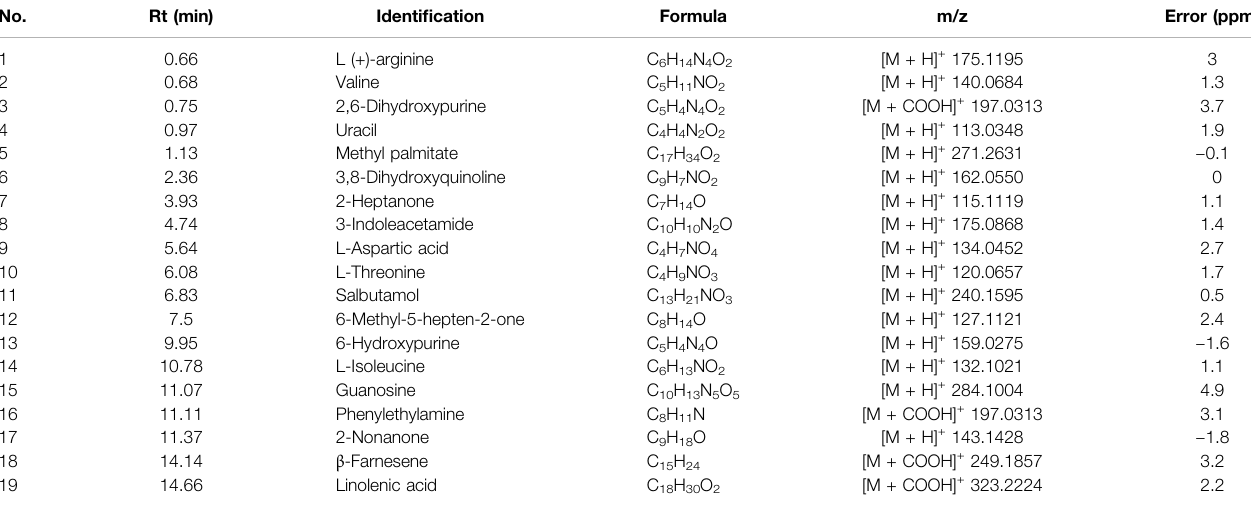
TABLE 2 | The mass information of the compounds identi fi ed in ZJS using HPLC-Q-TOF-MS.